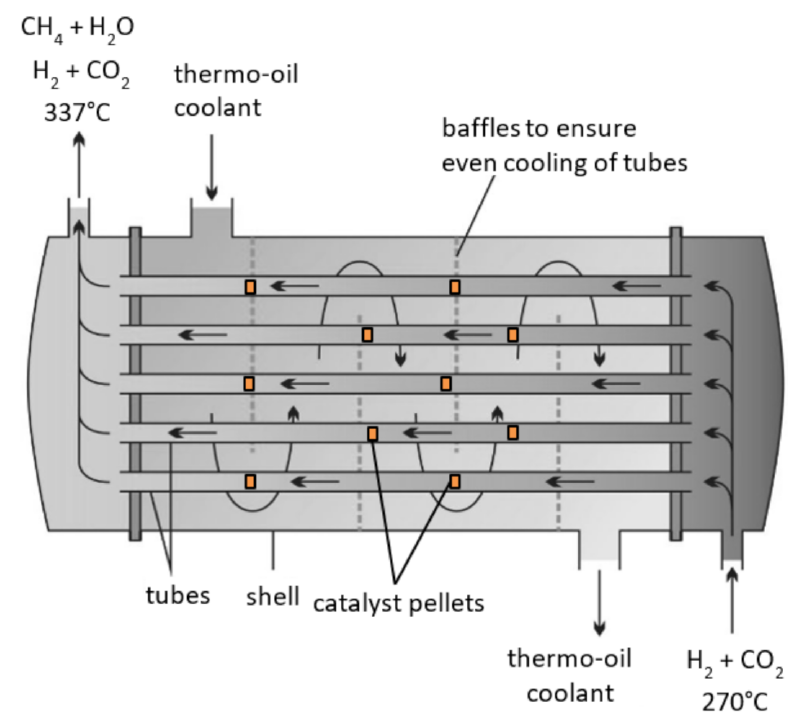
Figure 4. Schematic of reactor R-1. Adapted from Kuznik